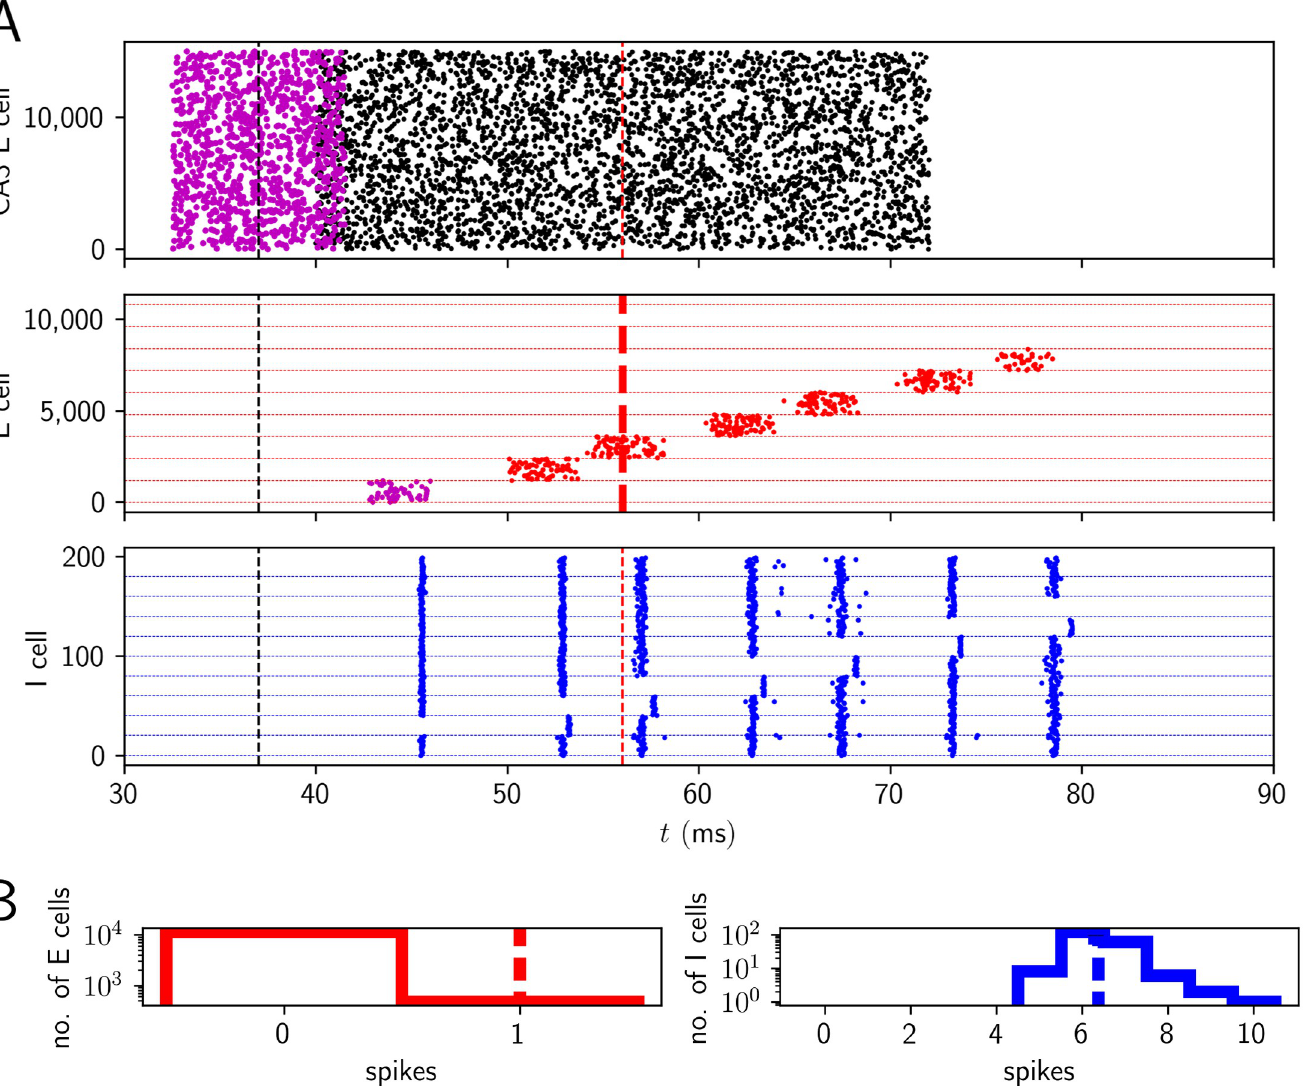
Fig 10. Replay events and ripple oscillations in model 3. Appropriately structured model 3 networks with relatively weak dendritic spikes generate replay and oscillations in the ripple frequency range through alternating E pulse and I gap coding. Active E cells contribute only one spike, while all I cells participate and spike in nearly every ripple. The populations are split into K + 1 = 10 groups forming a chain as in Fig 9A. The figure layout is similar to Fig 7. A, upper subpanel: Spikes generated by CA3. Middle: spike rastergrams of the CA1 E and I cells (red and blue). Example realization in a network with N = 12000 excitatory cells and N = 200 E I inhibitory cells generating replay together with an oscillation of frequency f � 190 Hz. Group E 0 receives input from an initializing CA3 population here consisting of 15000 neurons (magenta spikes, population size chosen like that of the main sharp wave to keep the connection probability constant across neurons). The remaining groups of excitatory cells receive unstructured input from N = 15000 different excitatory CA3 spike trains shown in black (for simplicity the same rastergram as E ,CA3 for the magenta spikes was used). About seven E and I groups are sequentially (de)activated, before the sequence terminates due to the termination of CA3 input. B: Histograms of spike counts. Parameters are as in Fig 8, except for those listed in S2 Appendix.